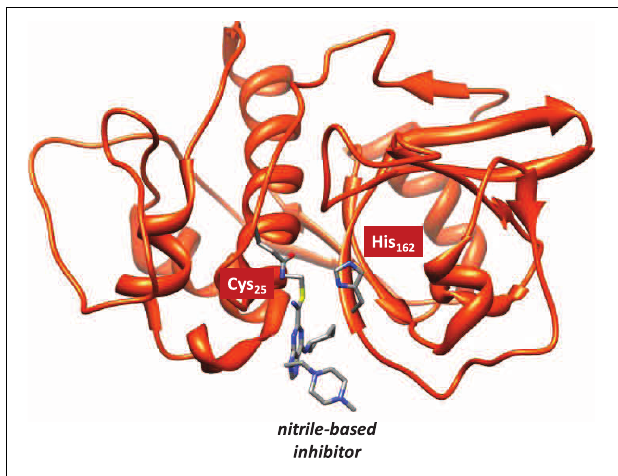
FIGURE 1 | Extract of the 1U9V pdb structure of cathepsin K with key amino acids and inhibitor